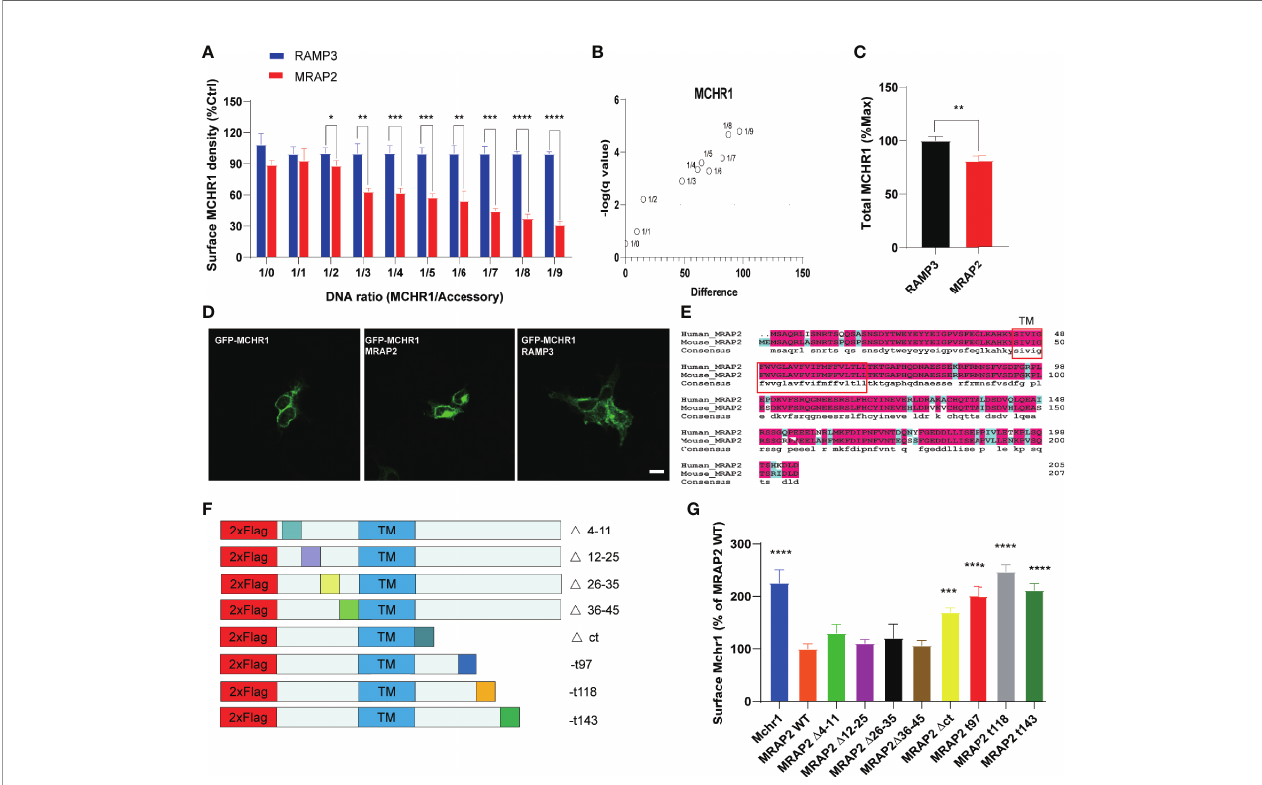
FIGURE 3 | Regulation of MCHR1 traf fi cking by WT MRAP2 and its mutants. (A) Surface expression of MCHR1 measured by ELISA assay, which transfected with MRAP2 at different ratios (from 1:0 to 1:9). (B) D-value of MCHR1 membrane surface expression in the control group (RAMP3) and MRAP2 group at different transfection ratios. (C) Total expression level of MCHR1. (D) Localization of GFP-MCHR1 by confocal microscopy, which transfected with empty vector (left) or MRAP2 (middle) or RAMP3 (right). (E) Sequence alignment of human and mouse MRAP2. (F) Schematic representation of the MRAP2 mutants constructed. (G) The surface expression of MCHR1 when co-transfected with empty vector (control), WT MRAP2, or different mutants. One-way ANOVA with post-hoc Tukey test. * p < 0.05, ** p < 0.01, *** p < 0.001, **** p <